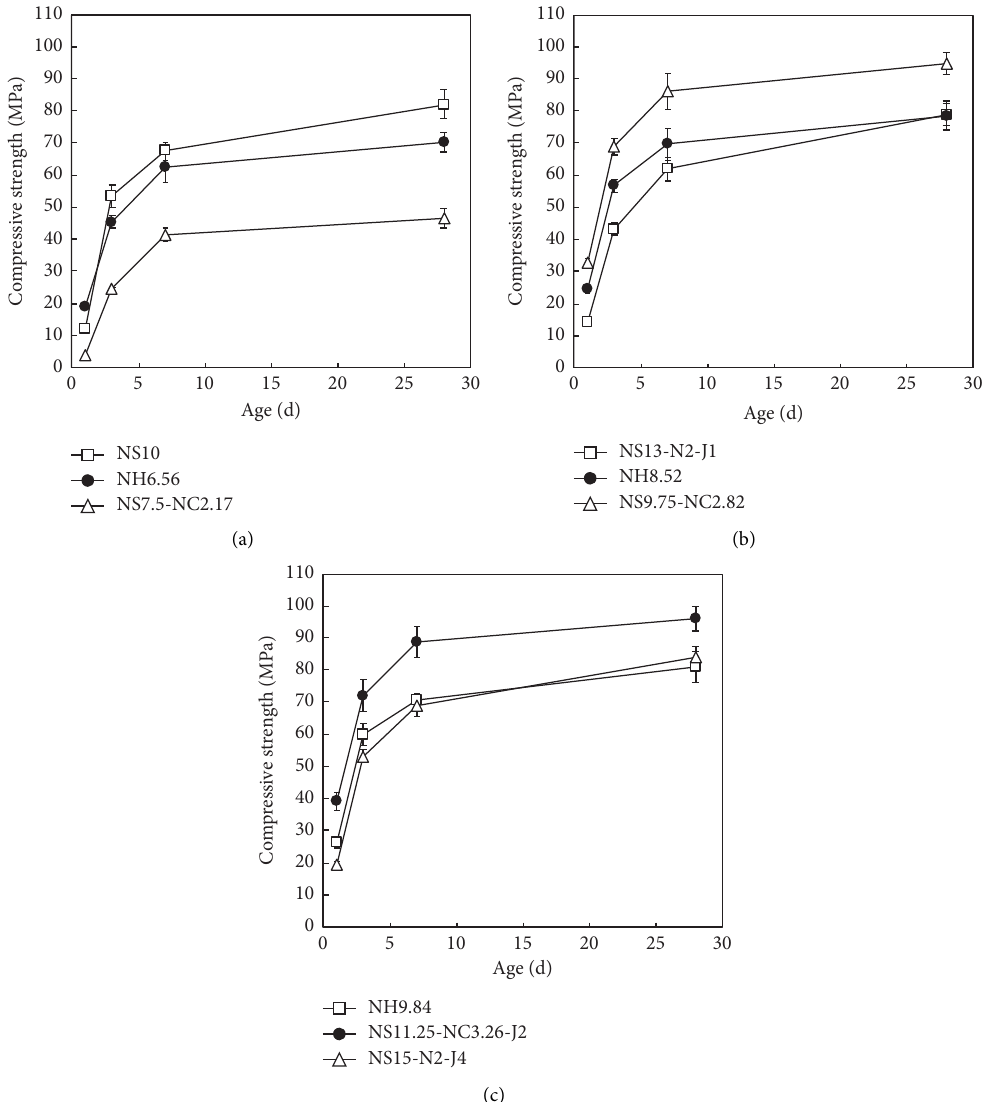
Figure 6: When n (Na � 0.082mol (a), n (Na � 0.107mol (b), and n (Na � 0.123mol (c), the compressive strength of an alkali- 2 O) 2 O) 2 O) activated nickel slag mortar is excited by different types of the alkali